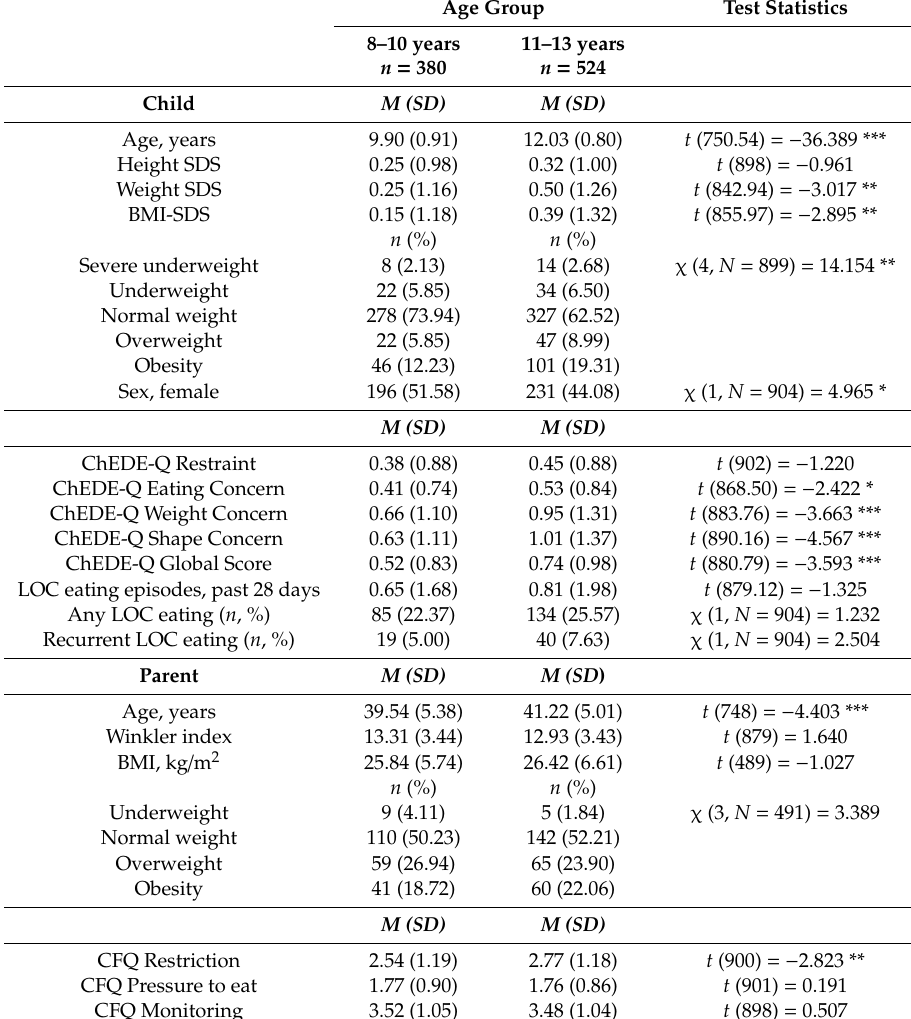
Table 1. Descriptive statistics on sociodemographic and anthropometric data, the Eating Disorder Examination-Questionnaire for Children (ChEDE-Q), and the Child Feeding Questionnaire (CFQ), separately reported for the young and old age